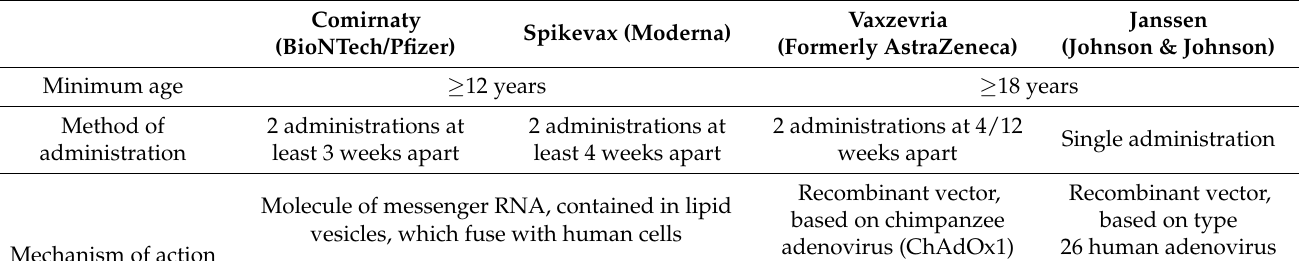
Molecule of messenger RNA, contained in lipid